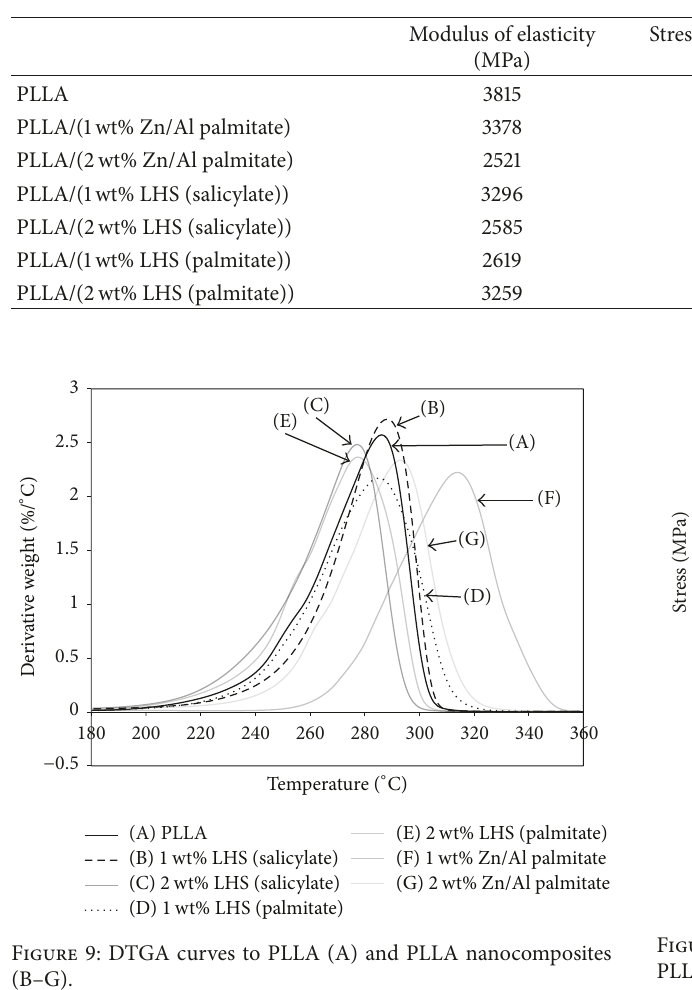
Table 2: Summary of some parameters obtained from flexure test.